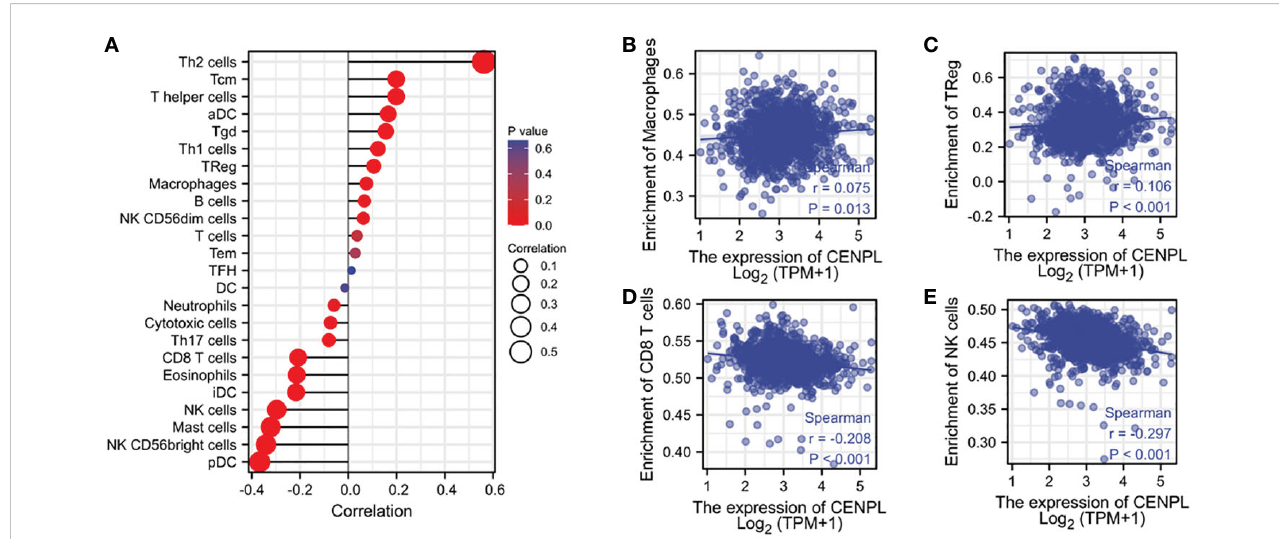
FIGURE 7 Associated between CENPL with immune cell in fi ltration. (A) Correlation between the expression level of CENPL and various immune cell in fi ltration. (B) Correlation between CENPL expression and macrophages. (C) Correlation between CENPL expression and Tregs. (D) Correlation between CENPL expression and CD8+T cells. (E) correlation between CENPL expression and NK cells.